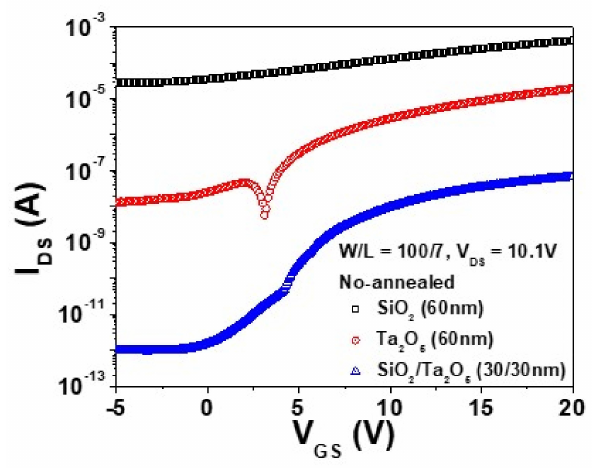
Figure 5. Transfer characteristics of a-IGZO transistors according to the gate insulating (SiO 2 (60 nm), Ta 2 O 5 (60 nm), and SiO 2 /Ta 2 O 5 (30 nm/30 nm)) films. The device is not annealed.